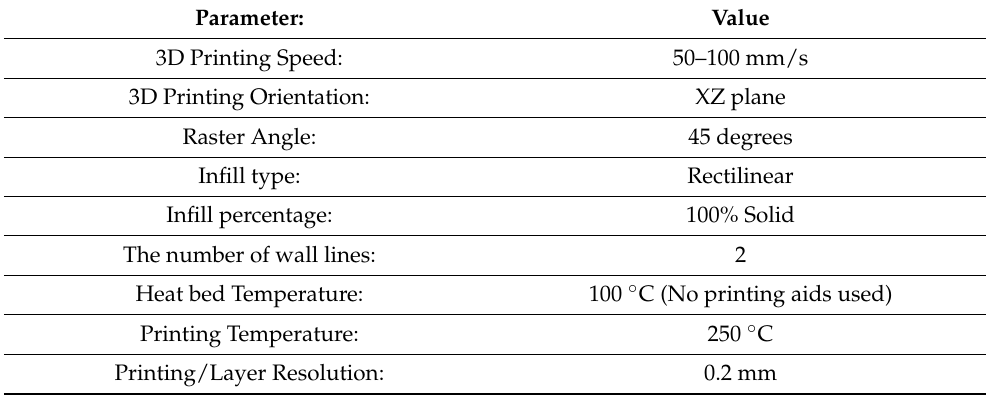
Table 1. Settings used for the manufacture of the specimens with the 3D printing process in this